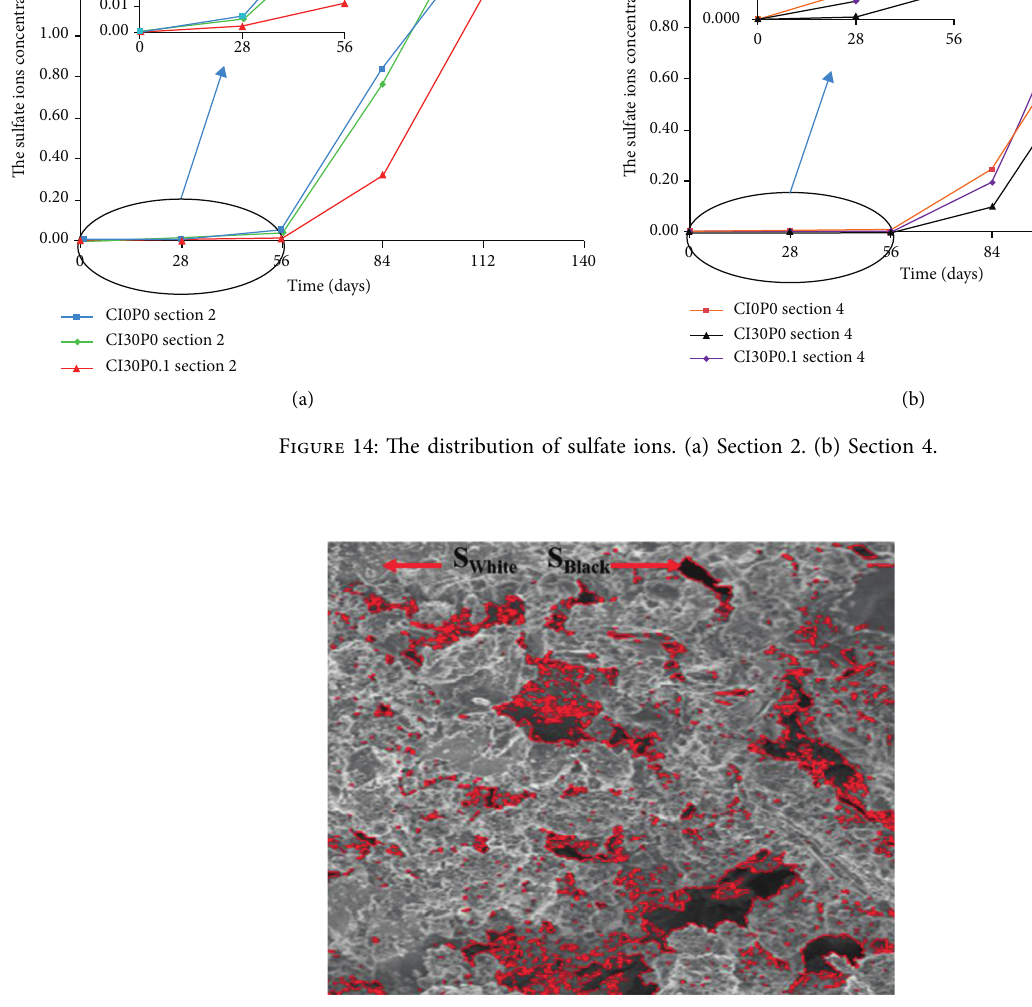
Figure 15: Black-and-white diversification diagram after IPP